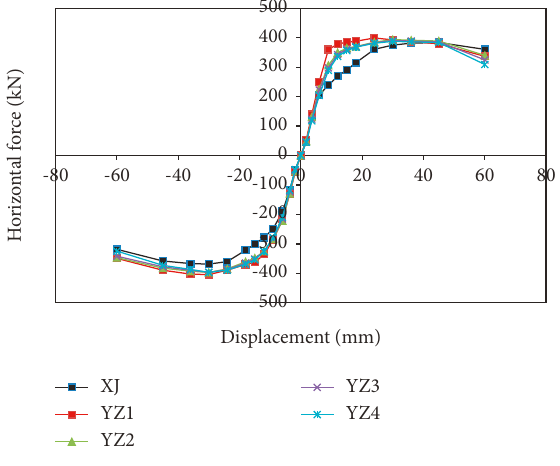
Figure 8: Skeleton curve. Table 3: Test values of bearing capacity.